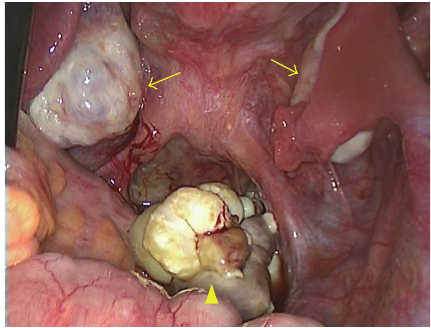
Figure 2: Laparoscopy showing normal ovaries (arrows) and a multilobular tumor in Douglas’ pouch (arrow